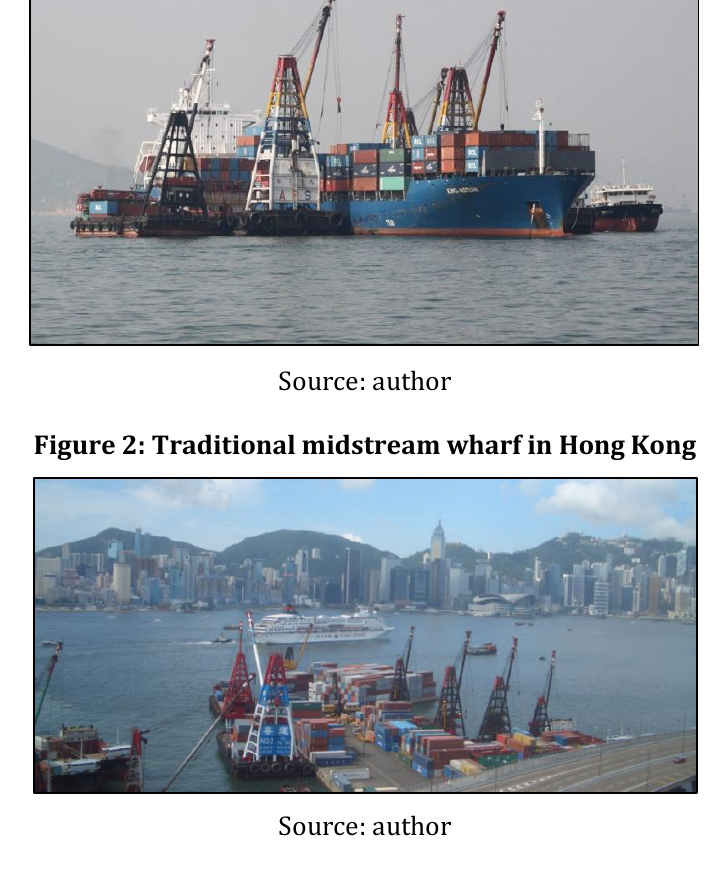
Figure 3: Hong Kong container throughput